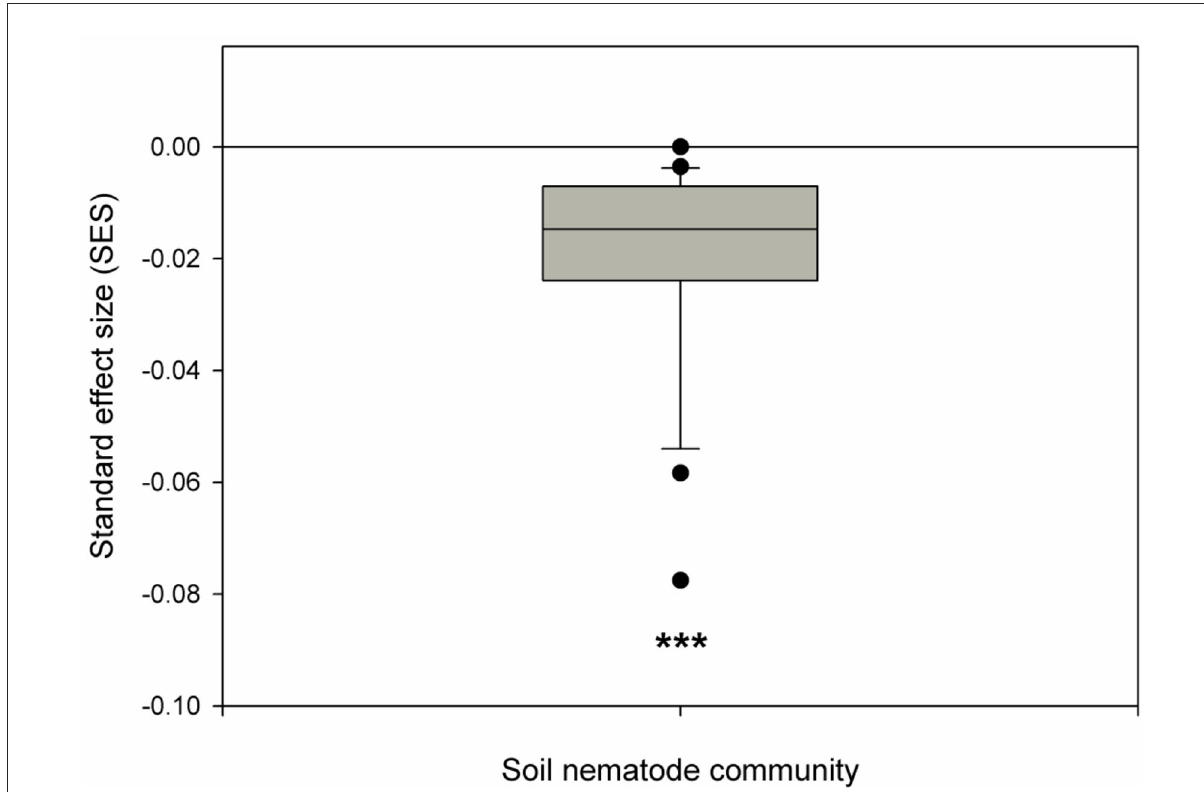
FIGURE2 Distribution of standard effect size (SES) of beta diversity in our primary tropical lowland rainforest. SES that is significantly greater than, smaller than, or approaching zero indicates significant trait divergence, trait convergence, or random distribution, respectively. The box plot shows the median (line within the box), 25 and 75th percentiles (the boundaries of the box), and 90 and 10th percentiles (error bars) of SES at each spatial scale. ***Indicates a p -value < 0.001 based on the Wilcoxon signed-rank